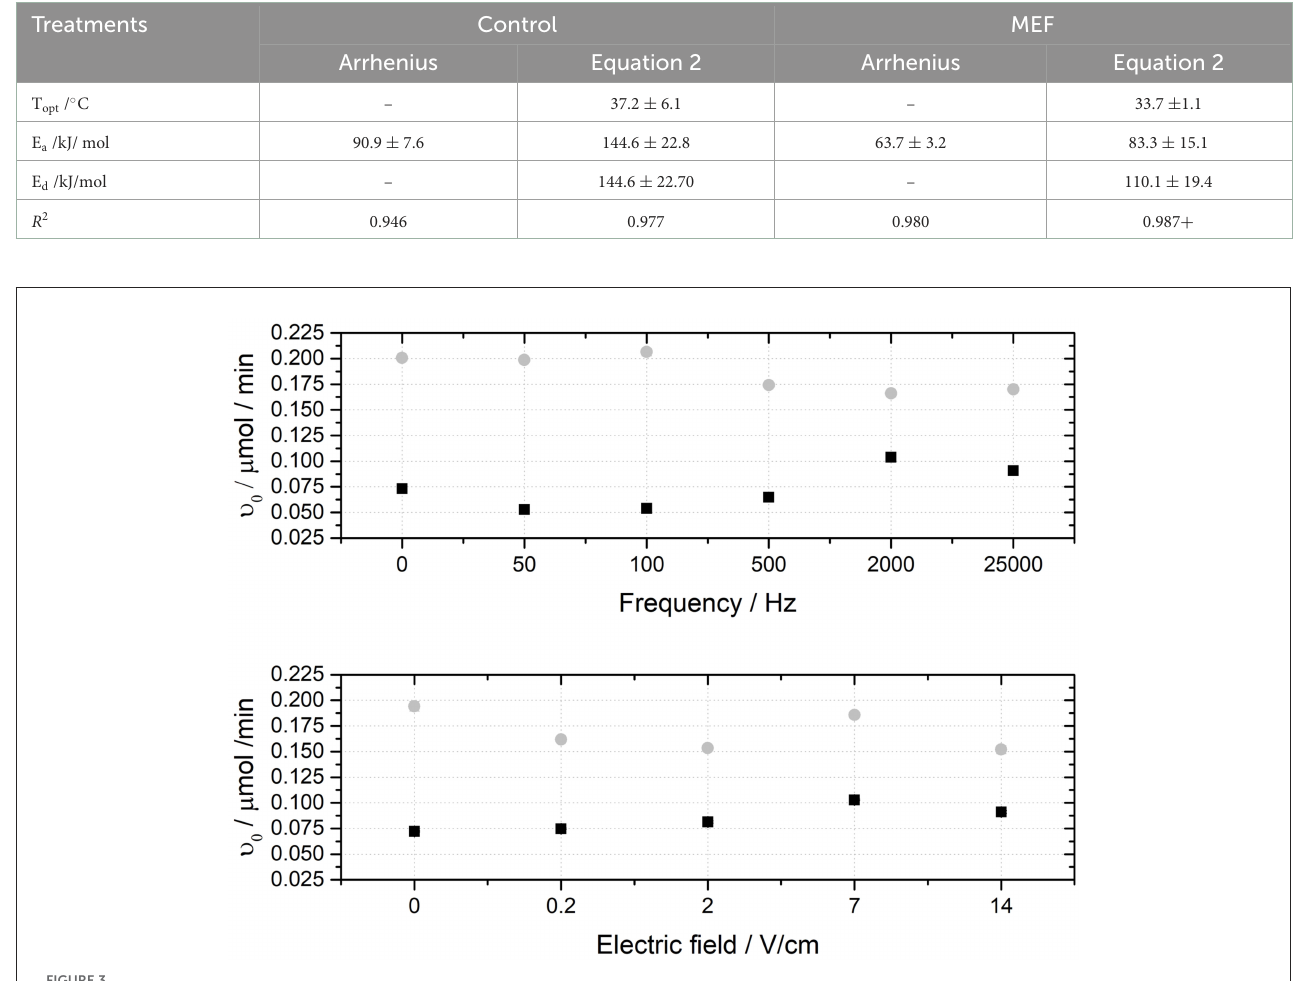
FIGURE3 PEC activity under different electric fields and electrical frequencies at 20 ◦ C (black squares) and 30 ◦ C (gray circles), with varying electrical frequencies (with a constant electric field of 7 V/cm) and varying electric fields (with a constant electrical frequency of 25kHz). Control assays correspond to 0 V/cm and 0Hz, and the standard error was < 7% for all